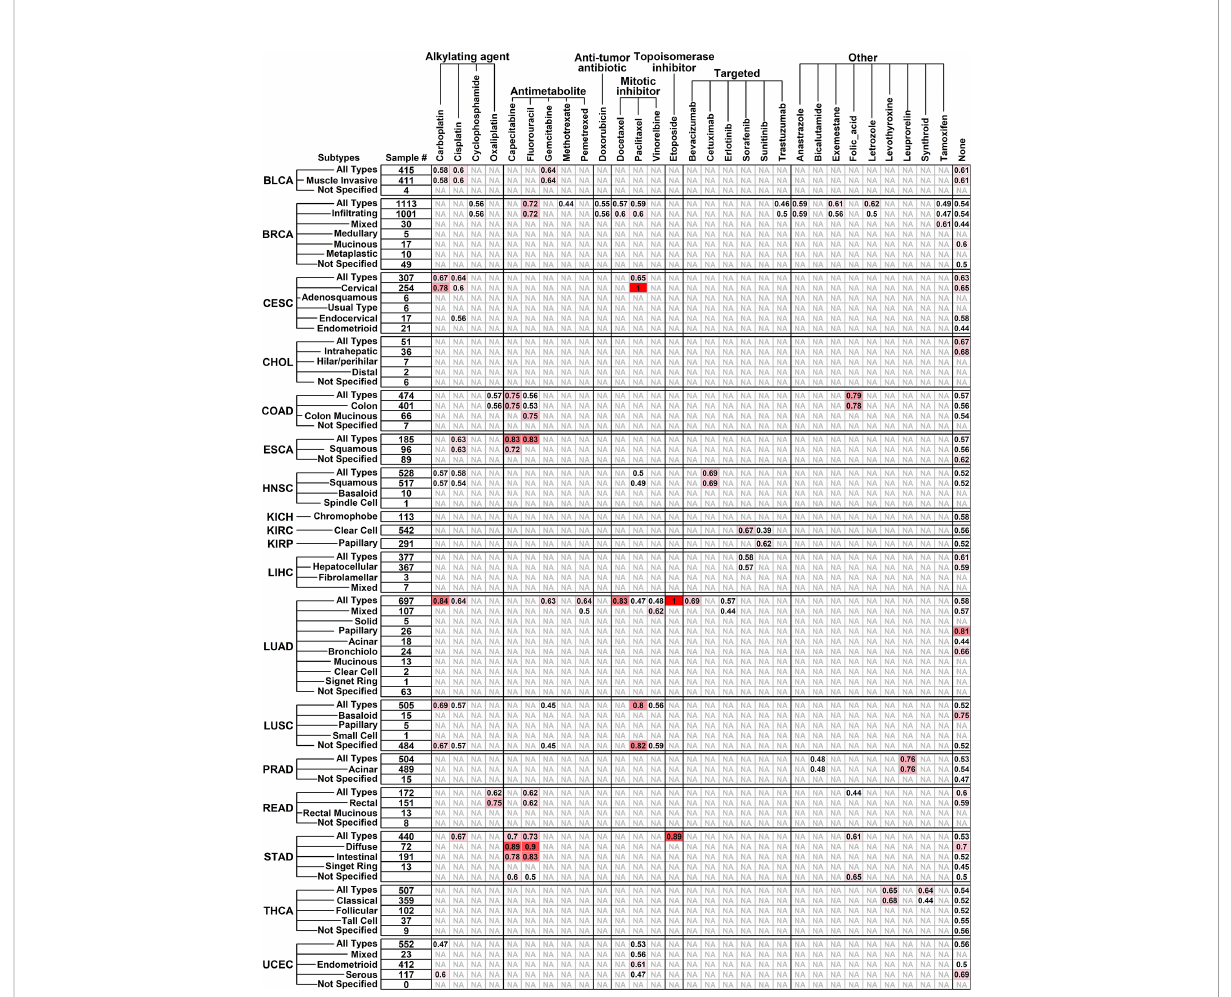
FIGURE 3 Performance of Pro and Con gene cohort in predicting different drug responses pan-cancer-wide. Tumor types/subtypes are listed on the left, and involved chemotherapy drugs are listed on top. AUC scores in separating drug-bene fi t samples from drug-futile samples under each drug/ cancer combination are listed, and an “ NA ” represents “ not applicable ” due to small sample size